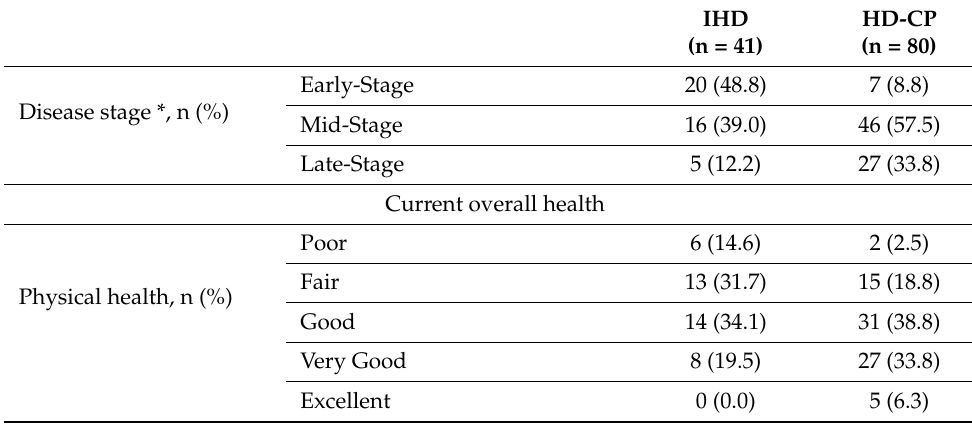
Table 2. Health characteristics of individuals with HD and care